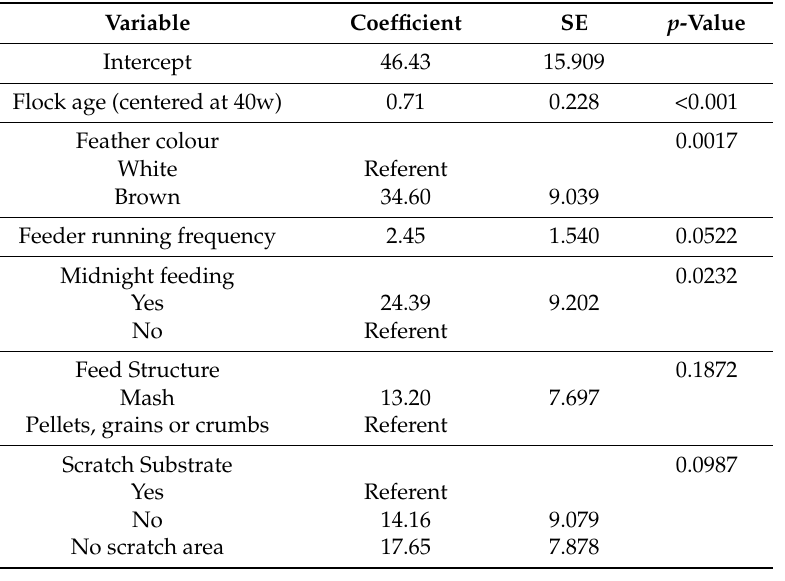
Table 5. Linear regression model of factors associated with feather damage prevalence in laying